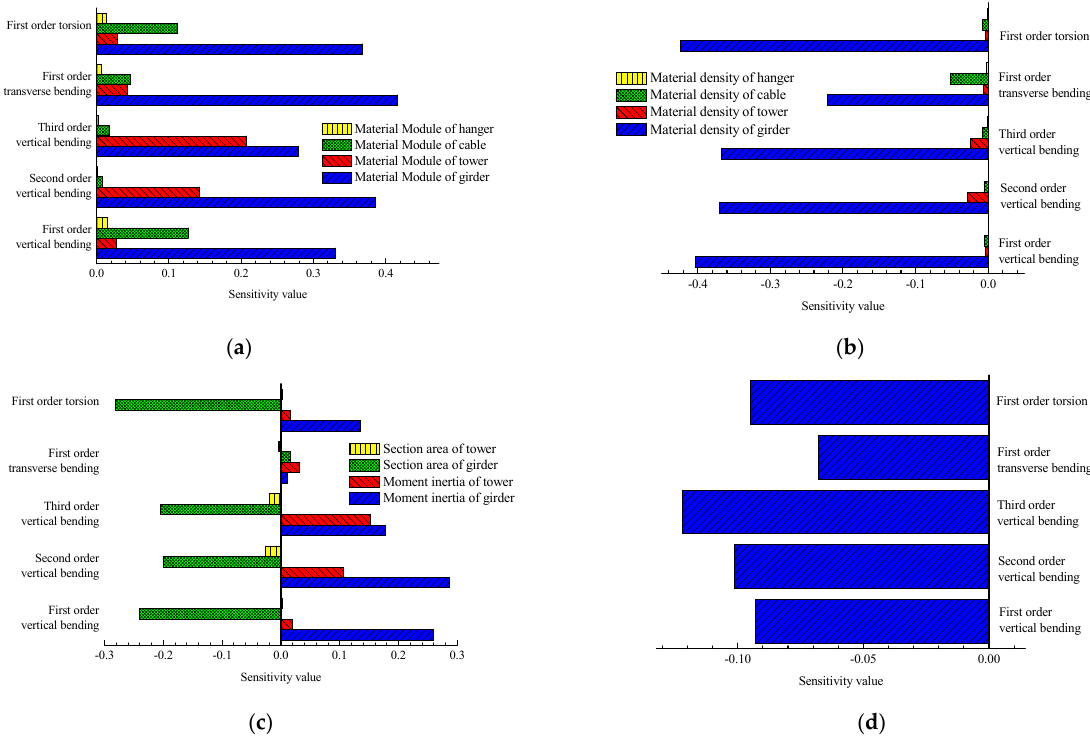
Figure 6. Sensitivity of parameters to frequencies: ( a ) Sensitivity of material modules to frequencies; ( b ) Sensitivity of material densities to frequencies; ( c ) Sensitivity of section characteristics to frequencies; ( d ) Sensitivity of secondary dead load to frequencies.